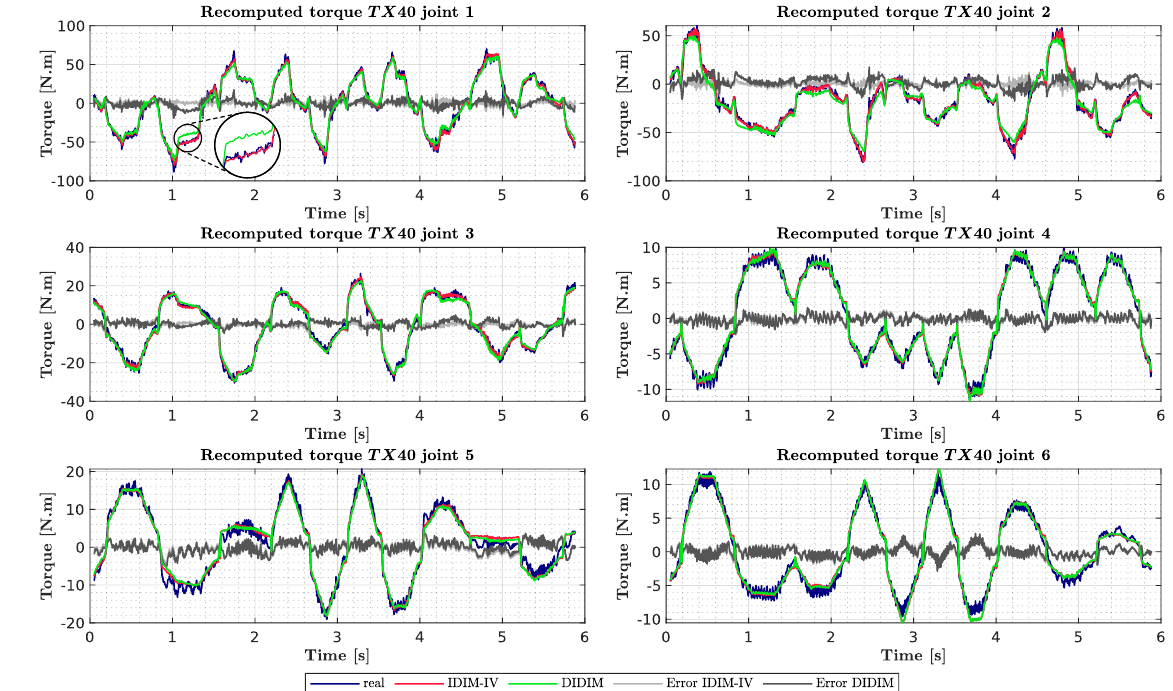
Figure 9. Reconstructed IDIM-IV and DIDIM torque signals during the validation experiment on the real TX40 robot.